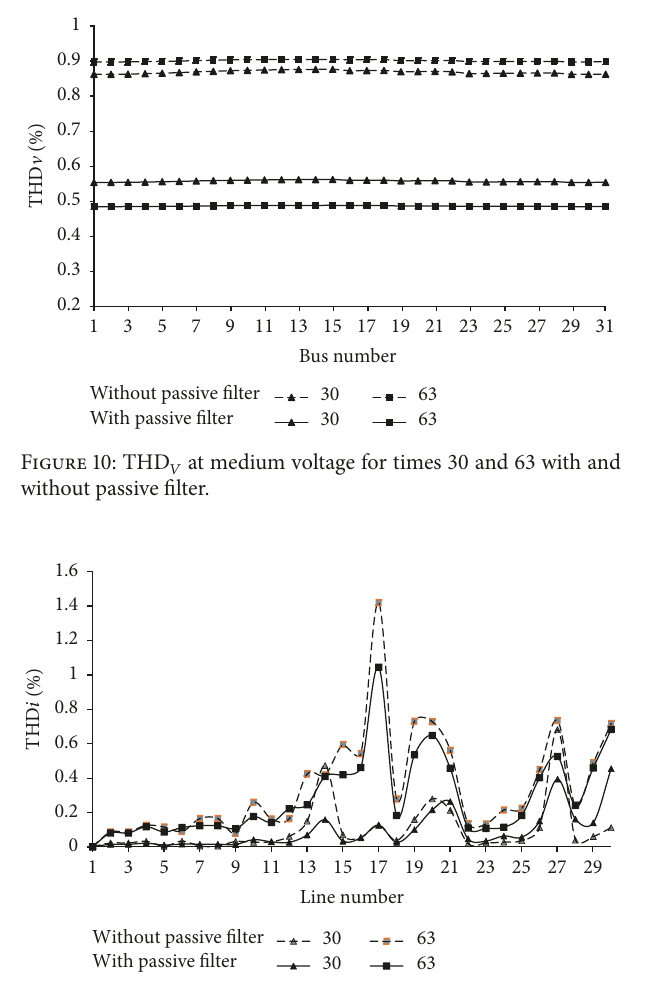
Figure 11: THD 𝑖 at medium voltage for times 30 and 63 with and without passive